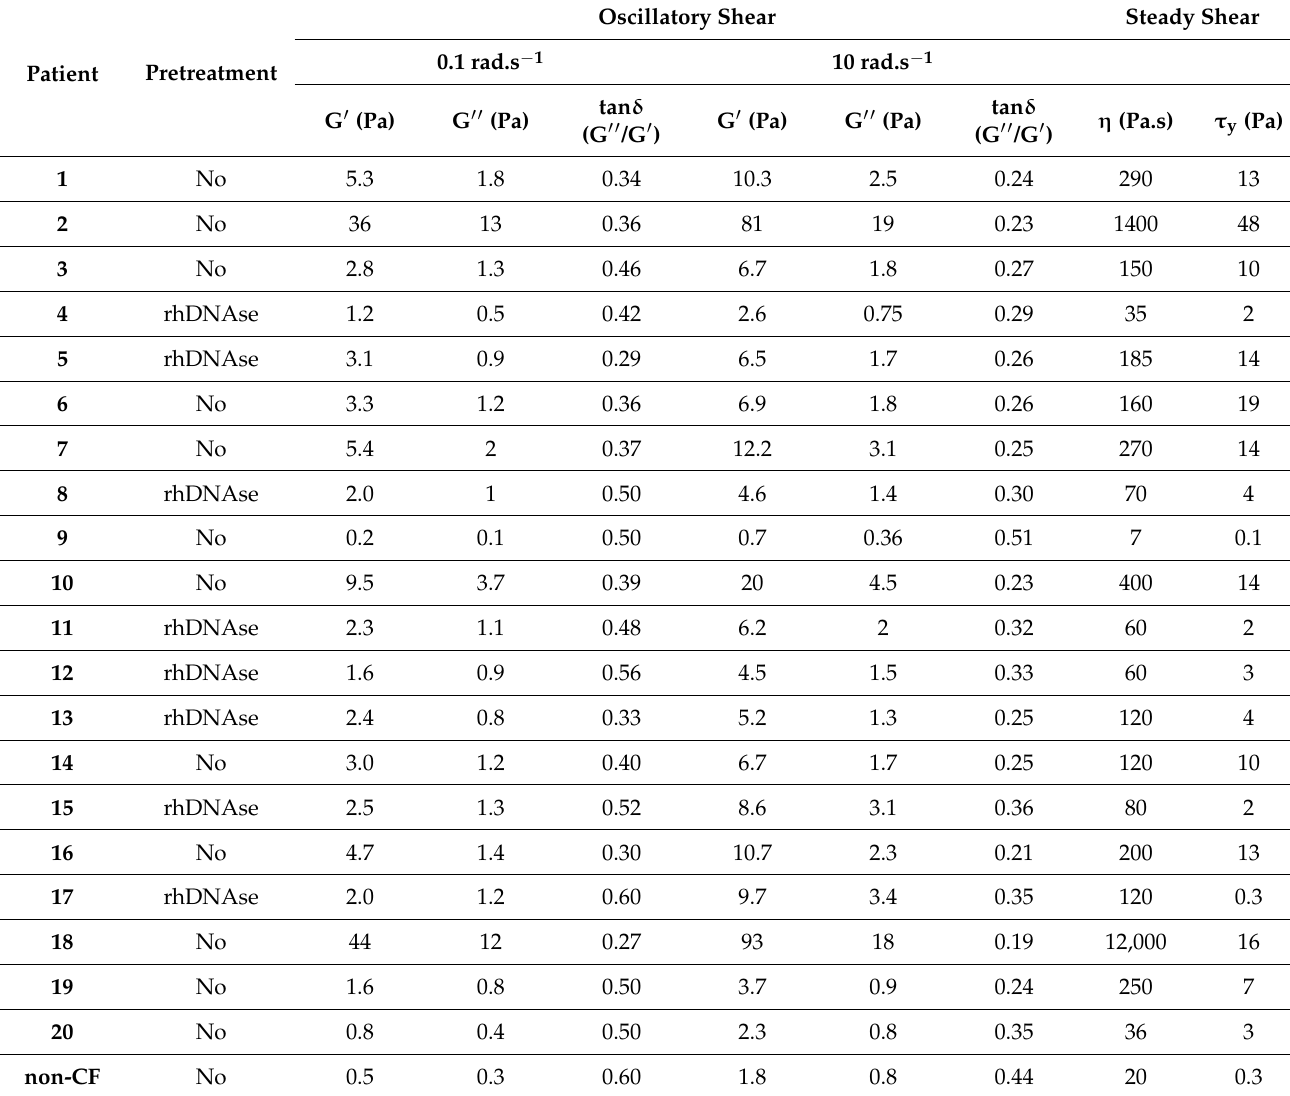
Table 2. Rheological characterization of CF sputa collected from patients who were previously treated, or not, with rhDNAse. The sputum obtained from a non-CF patient (collected by washing an endotracheal tube used during heart surgery) was used a reference. G (cid:48) and G (cid:48)(cid:48) data were measured at a strain amplitude of 1% and at an angular frequency of 0.1 rad.s − 1 and 10 rad.s − 1